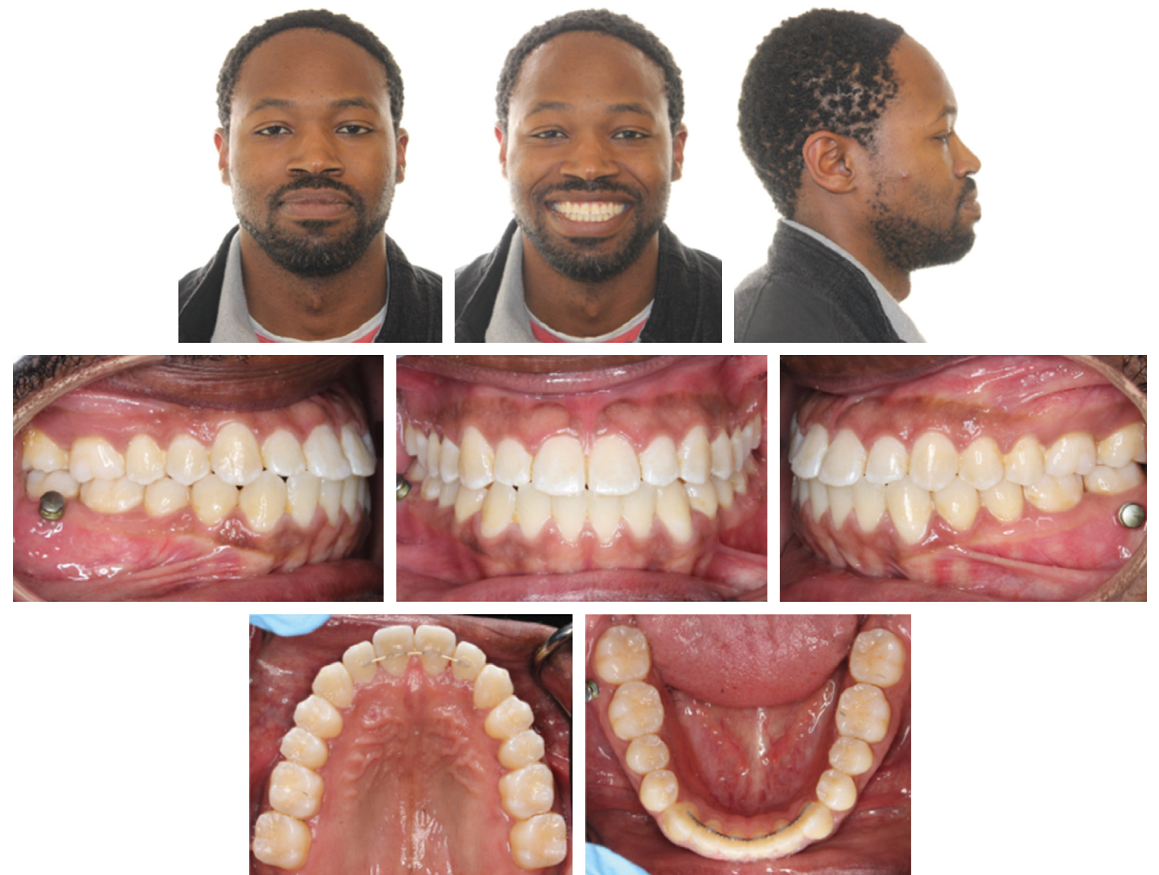
Figure 6: Posttreatment facial and intraoral photographs.